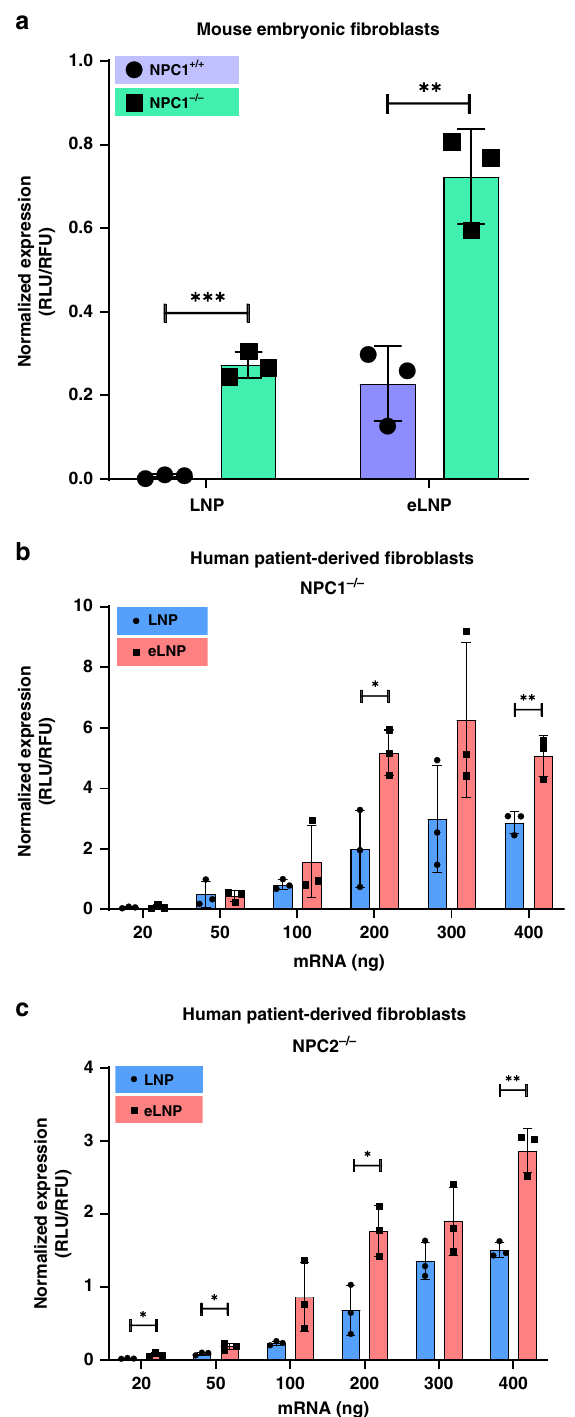
Fig. 5 Effect of defective cholesterol traf fi cking on eLNP-mediated gene transfection. LNPs and eLNPs were compared for their ability to deliver mRNA to a wild-type (WT) and NPC1 knockout (NPC1 − / − ) mouse embryonic fi broblasts (200 ng mRNA per well), and b patient-derived NPC1, and c NPC2 loss-of-function fi broblasts. All experiments were conducted with n = 3; mean ± SD. (* p ≤ 0.05, ** p ≤ 0.01, *** p ≤ 0.001. Signi fi cance was determined using multiple t -test.) Source data are provided as a Source Data fi